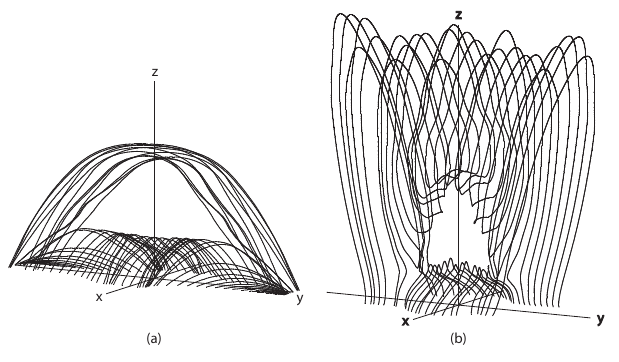
Fig. 3. Perspective view of magnetic field lines during plasmoid ejection, for (a) a force-free initial state and (b) a high- β case with a very small shear field.